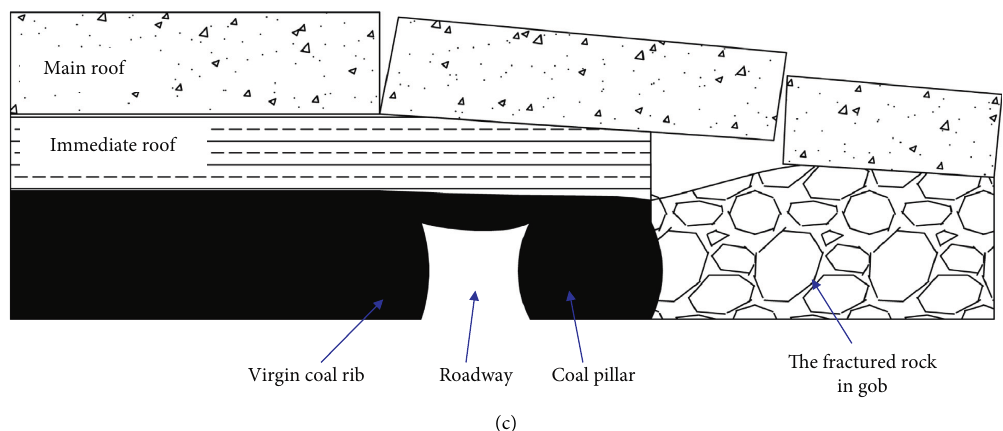
Figure 8: The movement process of roadway roof strata. (a) Initial movement of the strata. (b) Fracturing of the strata. (c) Rotation of the strata.